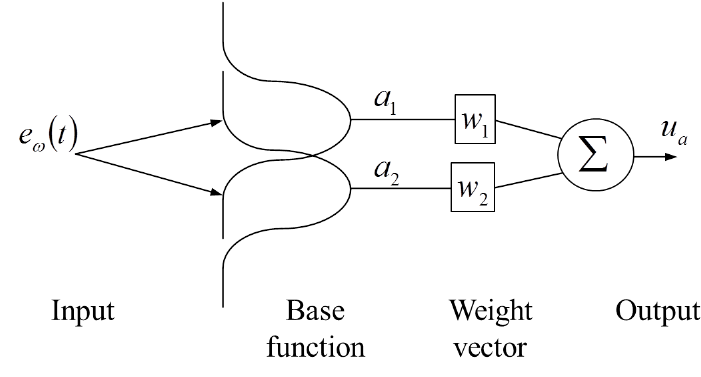
Figure 2. Proposed adaptive controller structure with the main